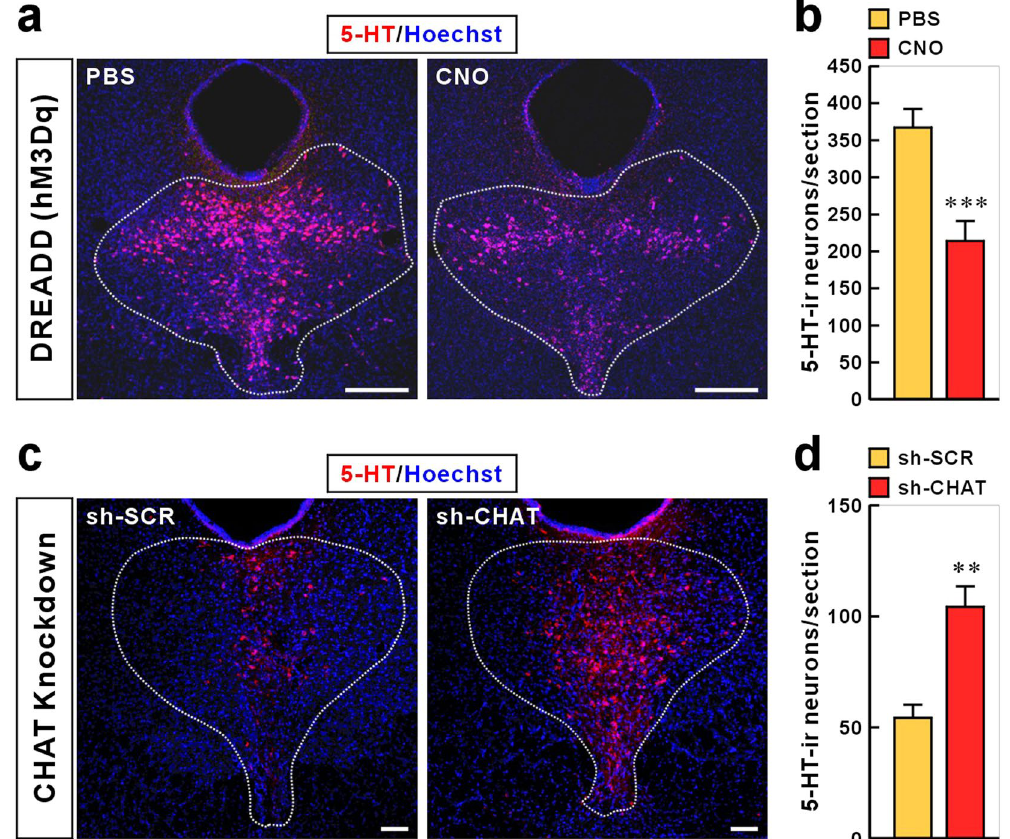
Figure 5. MHb cholinergic neurons regulate the population of 5-HT-immunoreactive neurons in the dorsal raphe nucleus. ( a and b ) DREADD mice expressing Cre-dependent hM3Dq were pharmacogenetically stimulated for 60 min using i.p. injection of CNO. Cell nuclei and 5-HT were visualized using Hoechst staining (blue) and Cy3 (red), respectively. CNO administration reduced the number of 5-HT-immunoreactive neurons in the DRN. Data represent mean ± SEM (PBS, n = 7 mice; CNO, n = 8; *** P < 0.001, Student’s t -test). Scale bar, 50 μ m. ( c and d ) CHAT knockdown effect on the number of 5-HT-immunoreactive neurons in the DRN. Immunohistochemical analysis was performed using rats that were used for behavioral tests in Fig. 2. Cell nuclei and 5-HT were visualized using Hoechst staining (blue) and Cy3 (red), respectively. CHAT knockdown increased the number of 5-HT-immunoreactive neurons in the DRN Data represent mean ± SEM (sh-SCR, n = 5 rats; sh-CHAT, n = 5; ** P < 0.01, Student’s t -test). Scale bar, 100 μ